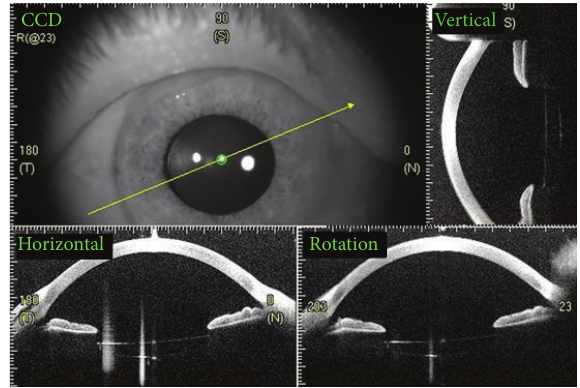
Figure 3: Anterior segment OCT showing IOL stability and cen- tration at 1 year after surgery. Vertical, horizontal, and rotational sections are